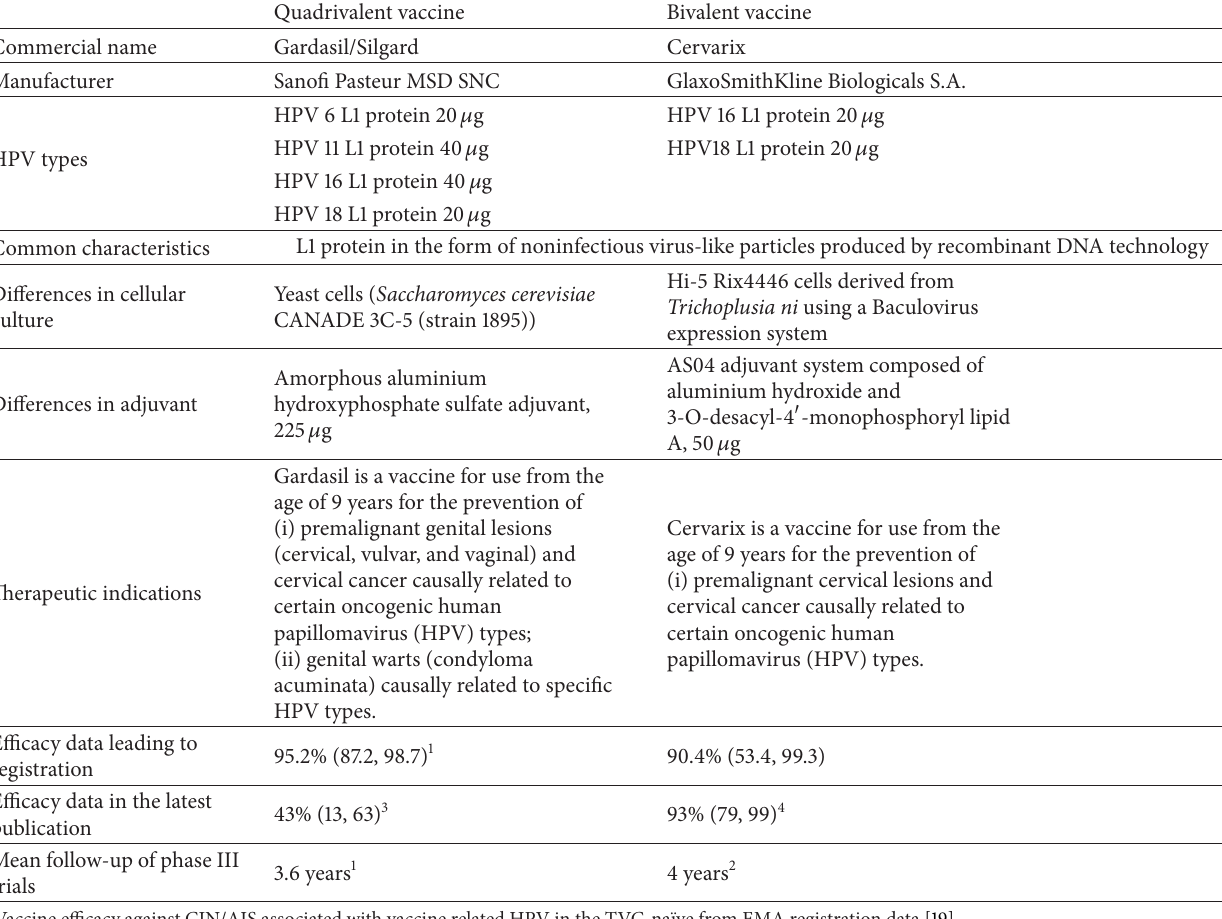
Table 1: Characteristics of bivalent and quadrivalent HPV